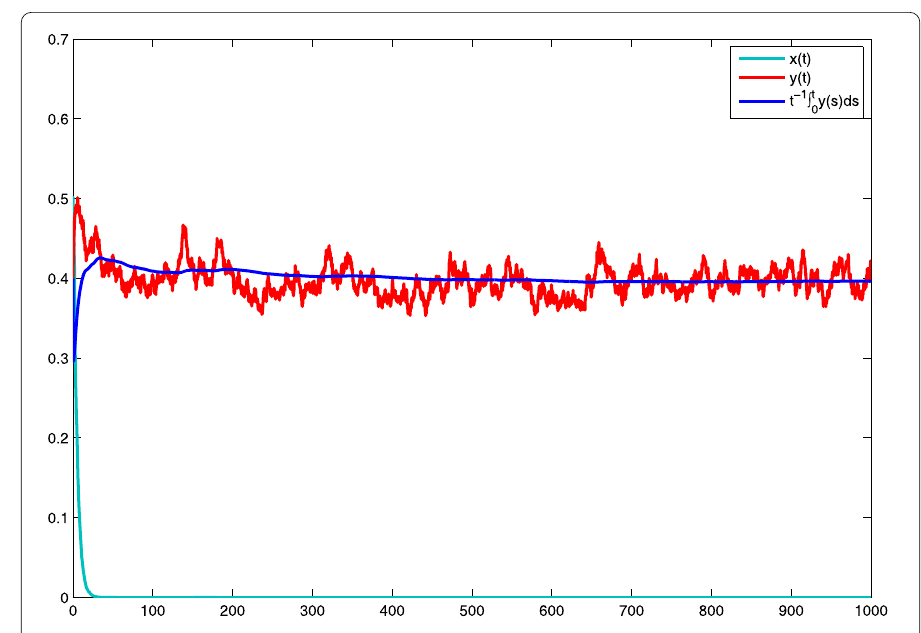
Figure 2 Solutions of model (3) with r 1 = 0.6, r 2 = 0.4, r 10 = 0.3, r 20 = 0.2, ξ 2 1 = 1.43, ξ 2 2 = 0.63, a = 0.4, c = 0.36, f = 0.25, h = 1. With α 1 = 0.55, α 2 = 0.525